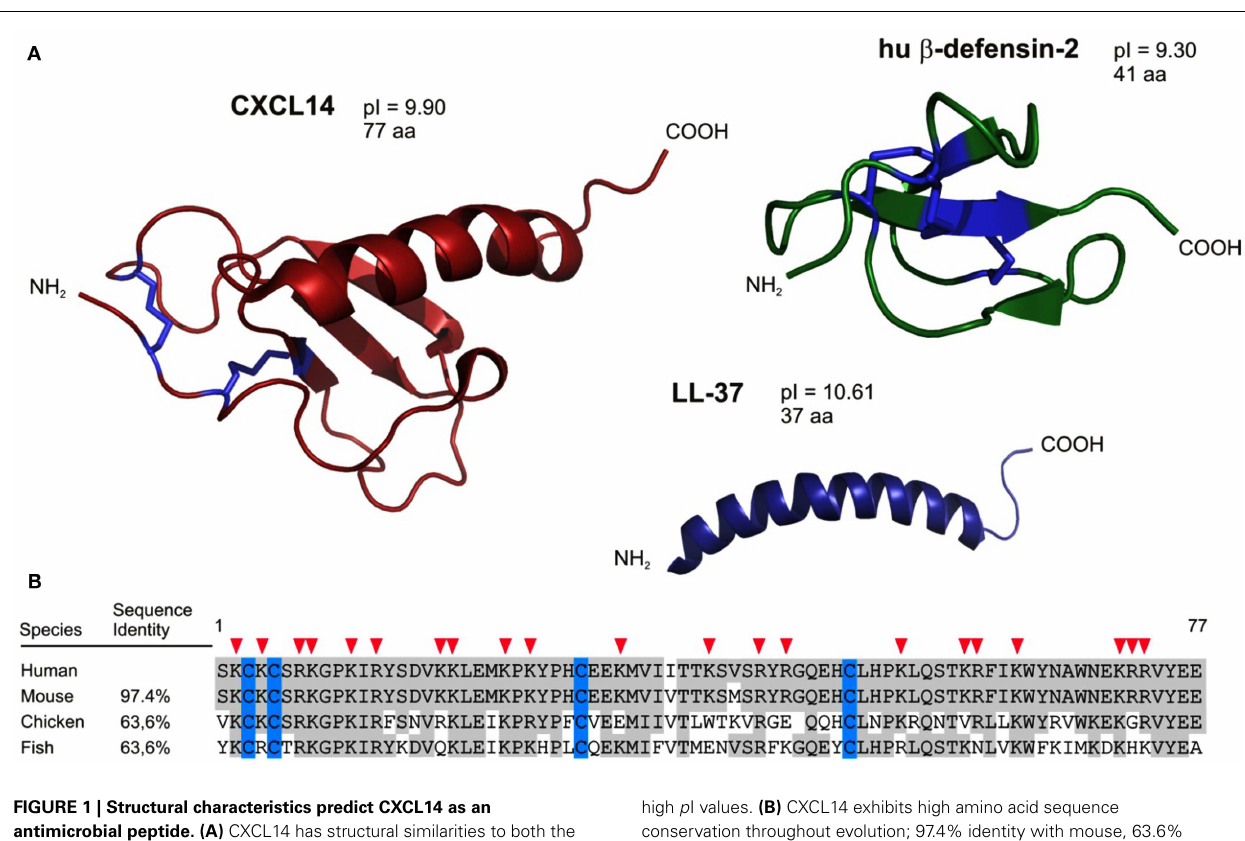
FIGURE 1 | Structural characteristics predict CXCL14 as an antimicrobial peptide. (A) CXCL14 has structural similarities to both the defensin family (anti-parallel β -sheets) and the cathelicidins (C-terminally located α -helix). In addition, antimicrobial peptides and CXCL14 comprise